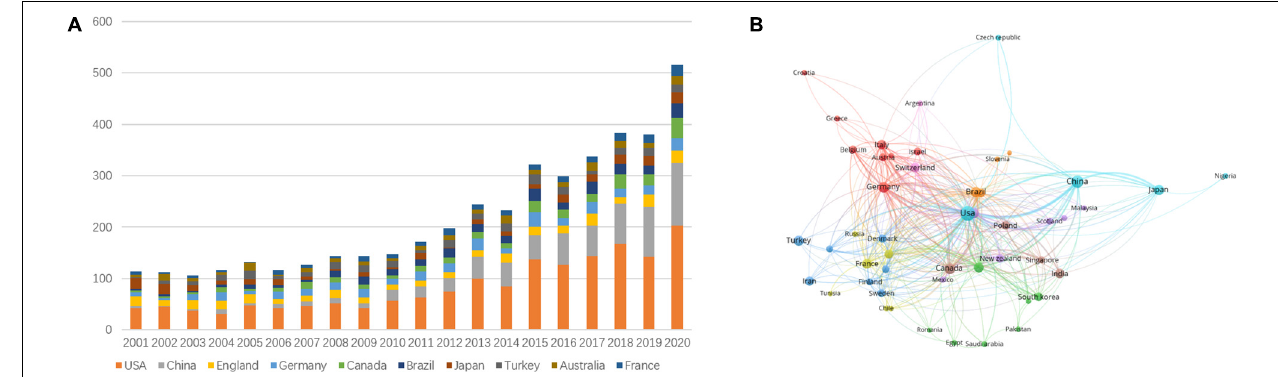
FIGURE 1 | The year and country in which the articles on ketamine were published. (A) The number of articles published in different countries each year. (B) The country contact map for co-published articles.